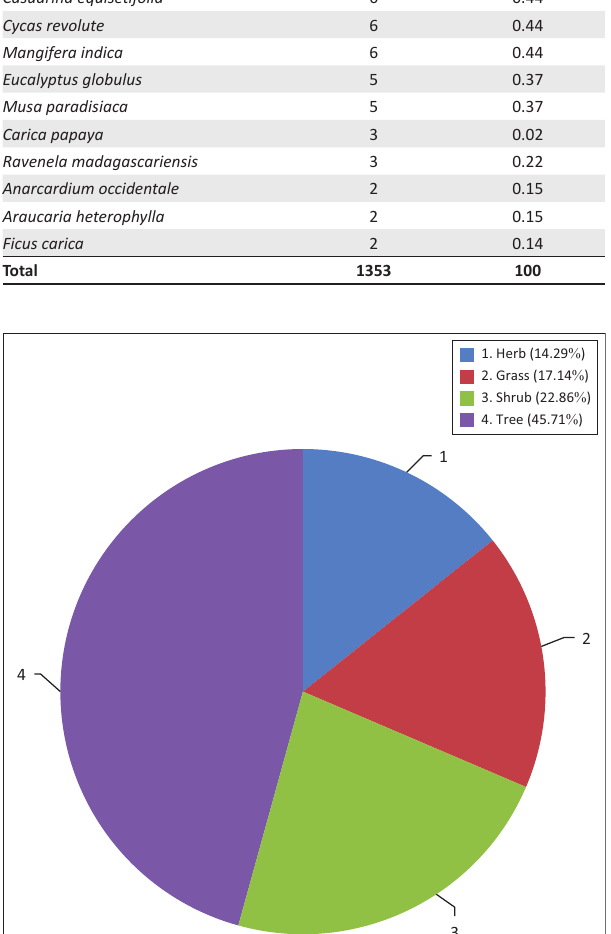
FIGURE 2: Distribution of plant habit within Lagos State University